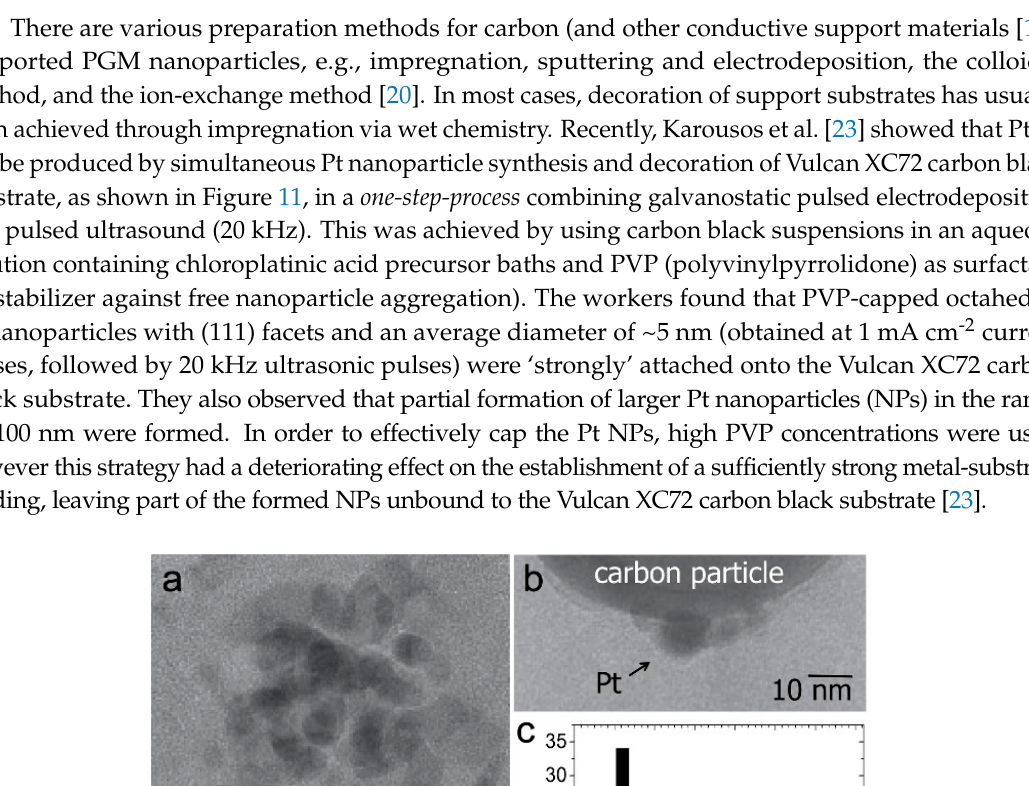
Figure 10. (Clockwise) TEM image, X-ray energy dispersive spectrometry, and XRD patterns of Pt nanoparticles [22].